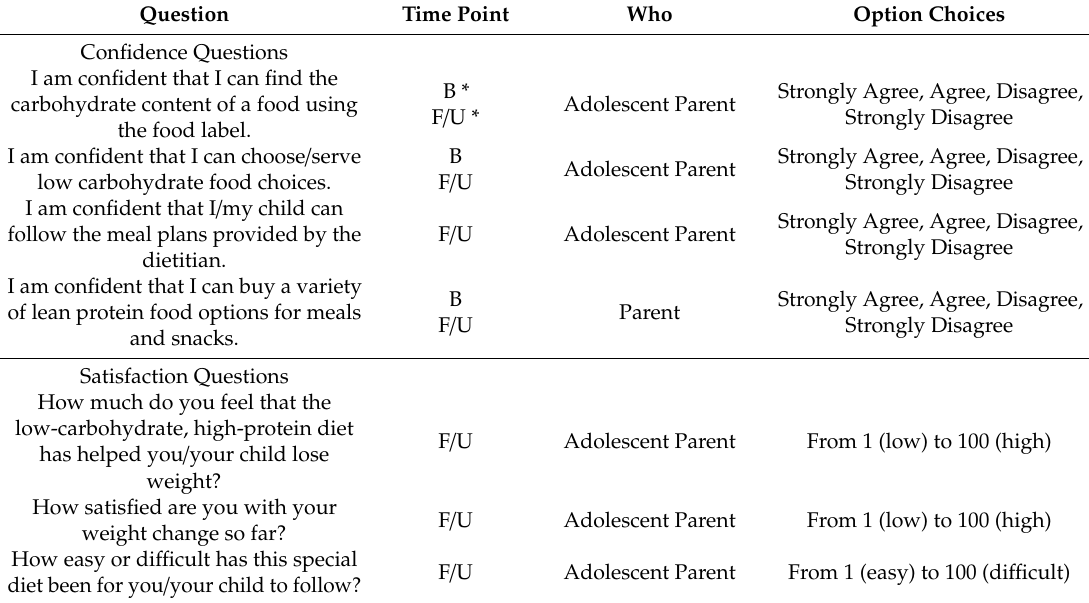
Table 2. Survey questions assessing adolescent and parent confidence and satisfaction with the